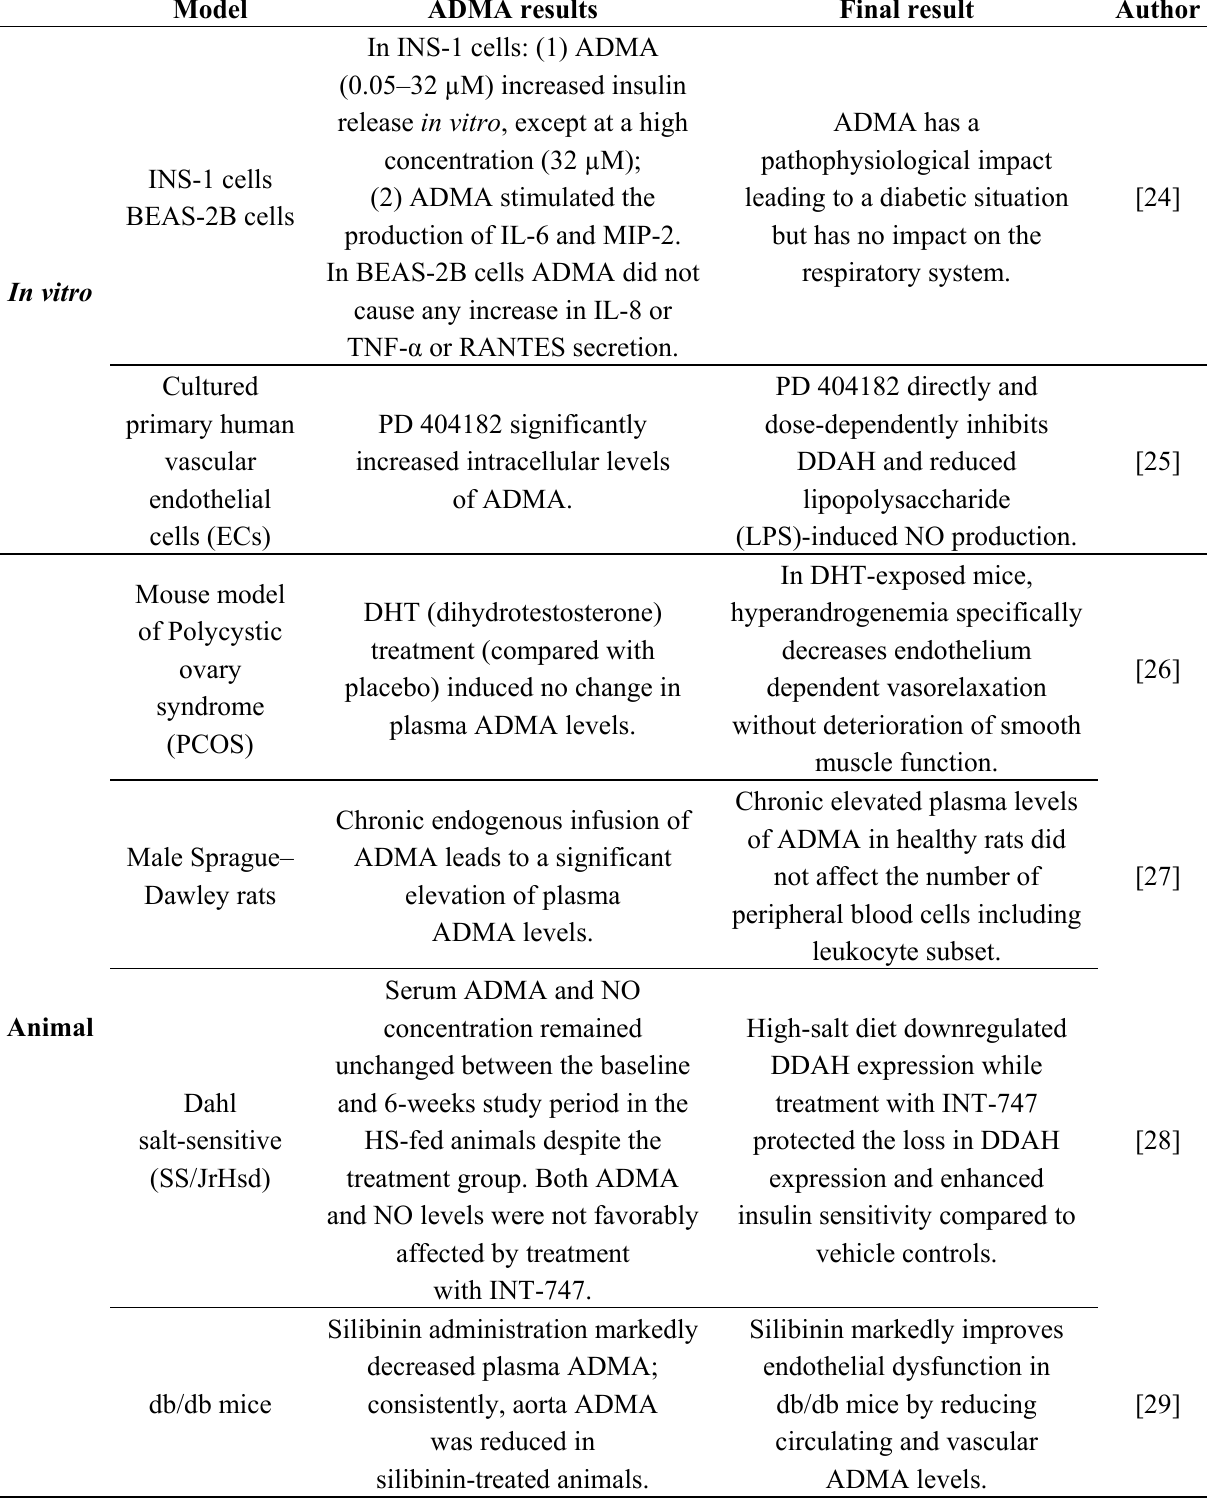
Table 1. Overview of the in vitro , animal and human studies on ADMA.